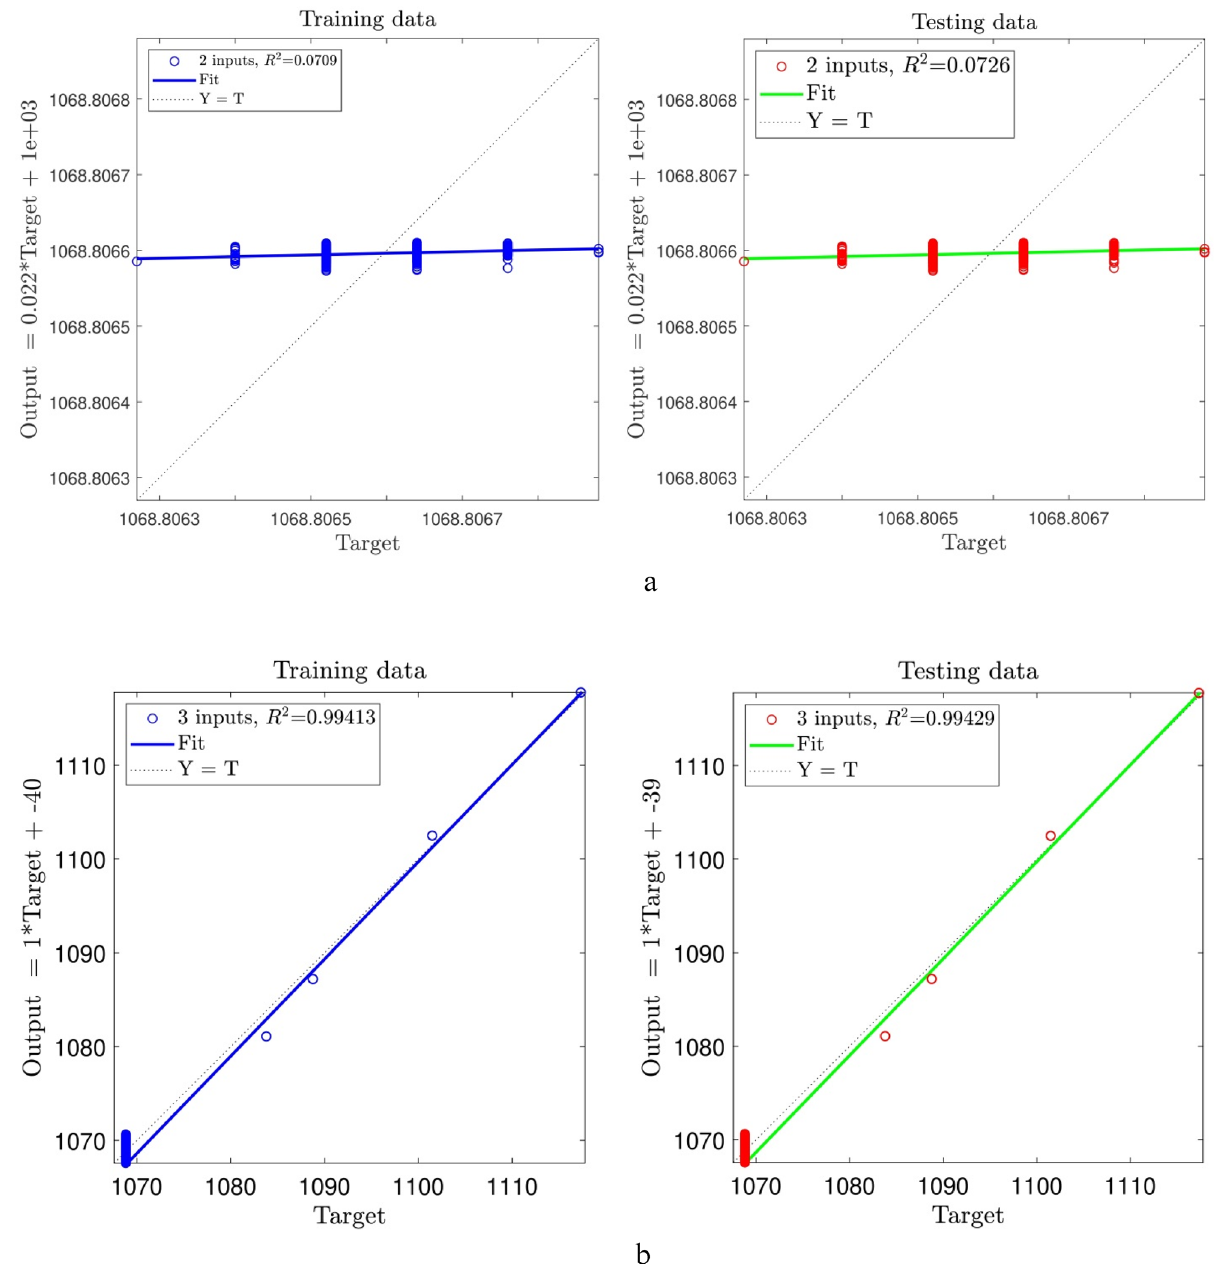
Figure 4. ( a ) Regression plot of the best of ACOFIS intelligence using two inputs in learning process. ( b ) Regression plot of the best of ACOFIS intelligence using three inputs in learning